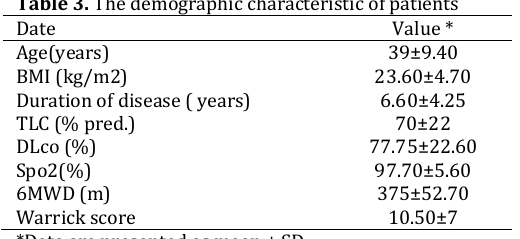
Table 3. The demographic characteristic of patients Date